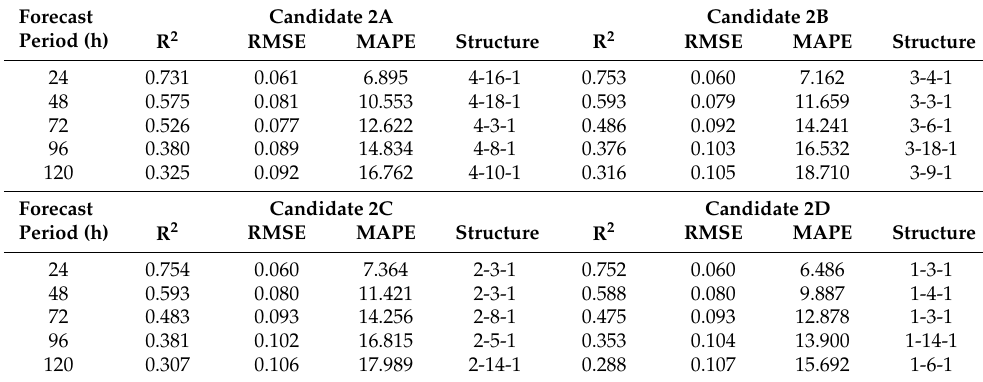
Table A4. The validation results of the combined model(LWL) fitted with ANN.